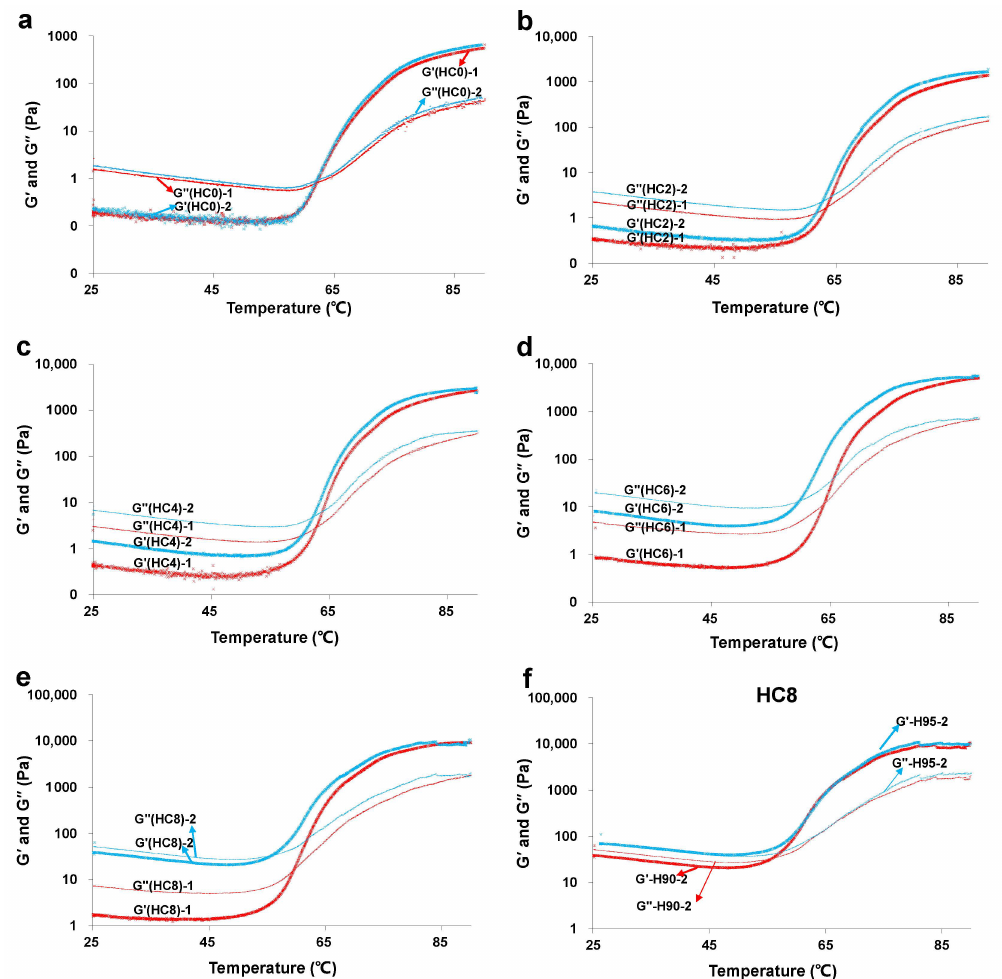
Figure 3. Temperature sweep curves for the first and second sweeps of the HPMC/CL blends: HC0 ( a ); HC2 ( b ); HC4 ( c ); HC6 ( d ); HC8 ( e ); and the second temperature sweeps of HC8 after the first temperature sweep heating at 90 ◦ C and 95 ◦ C, respectively ( f